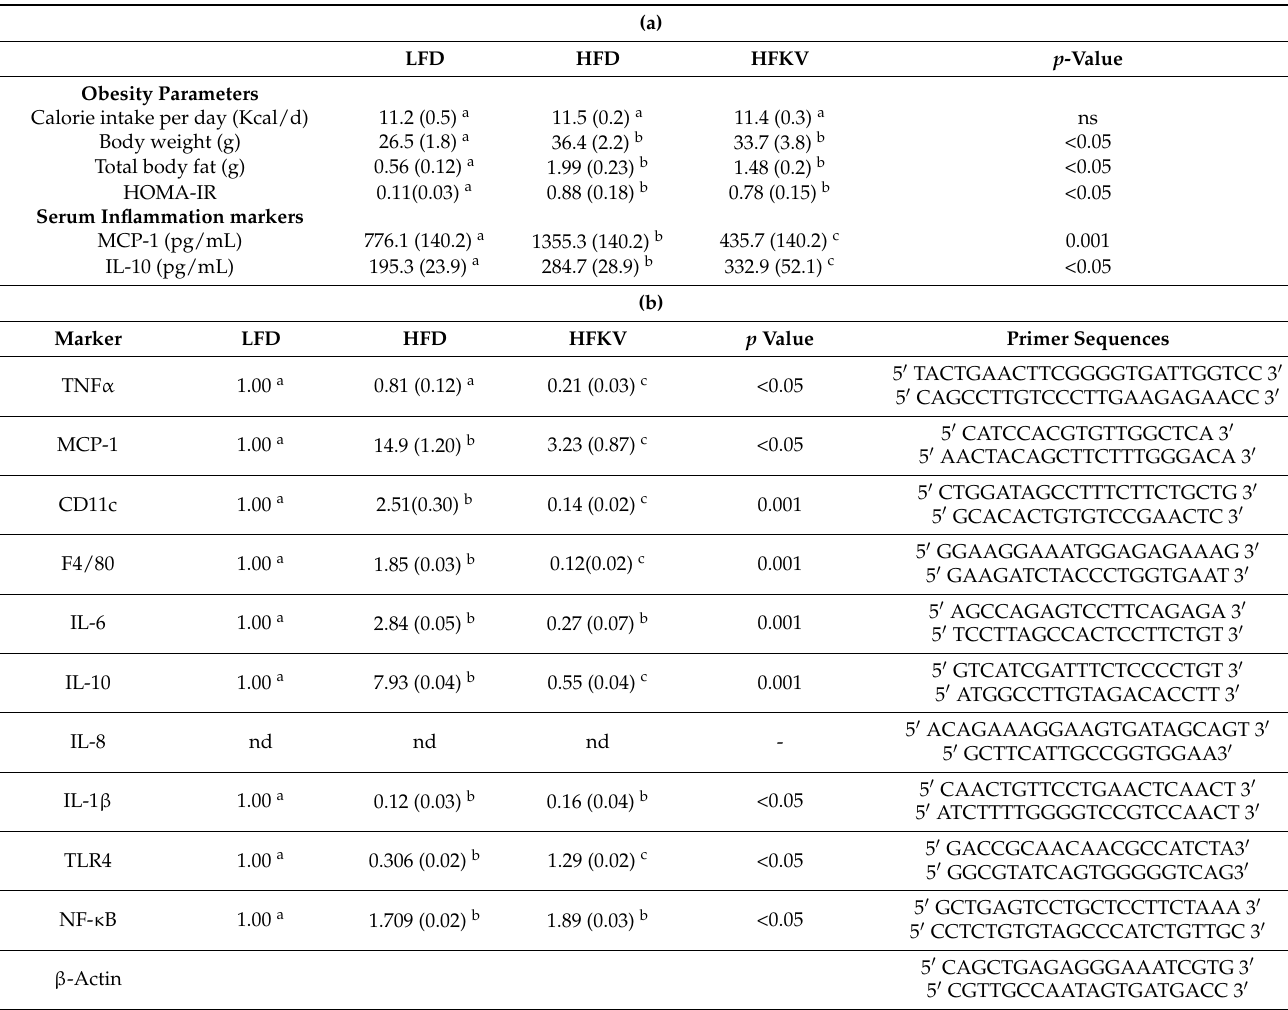
Values represent mean and standard error (SE). Different letters in superscript indicate significant differences between the diet groups; ns = non-significant, nd = not